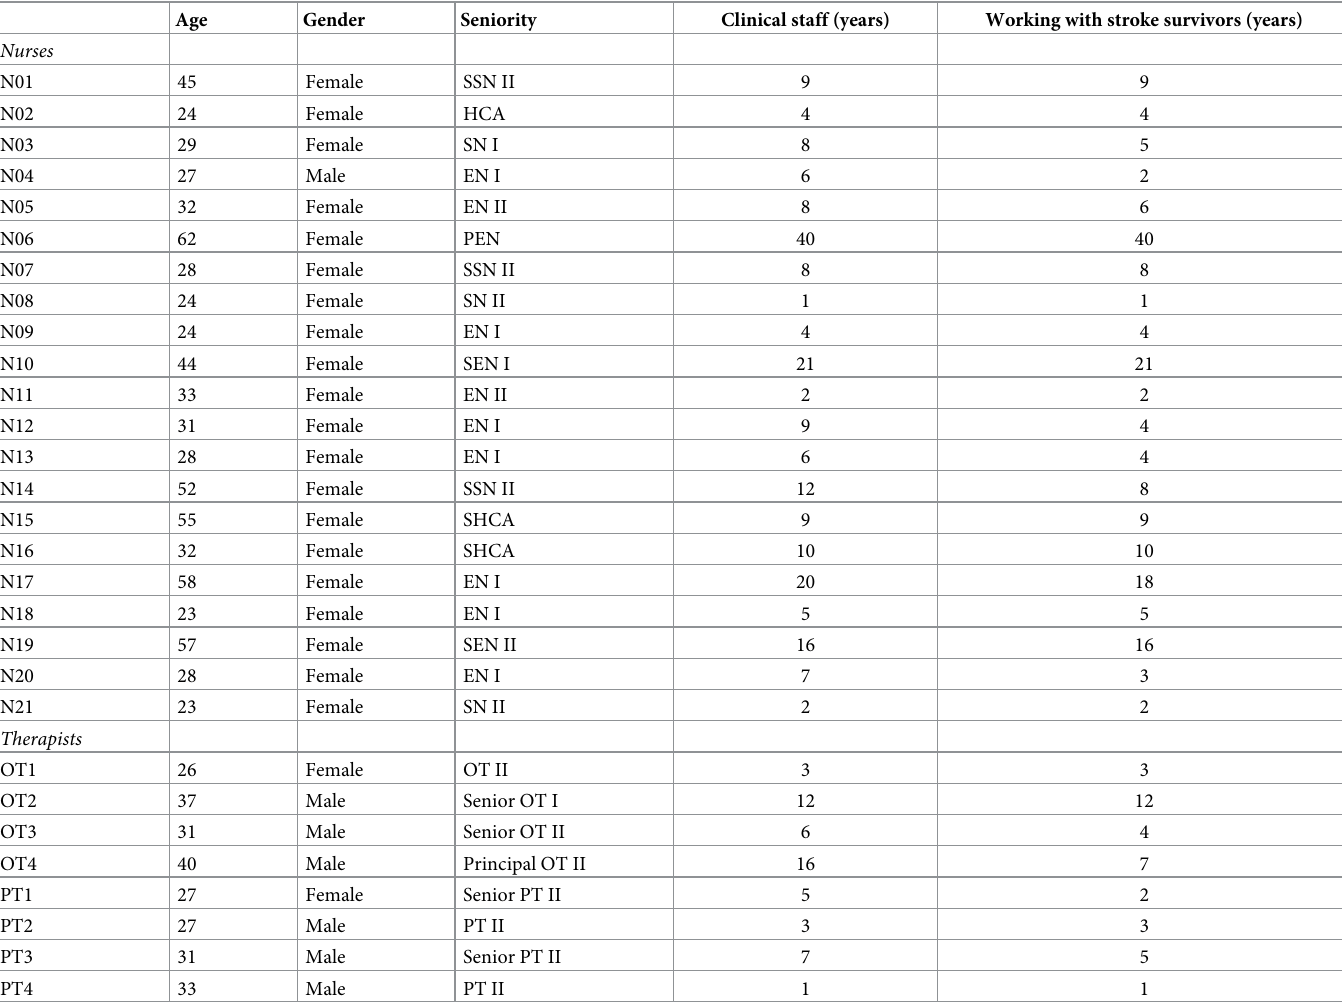
Table 2. Characteristics of participants in focus